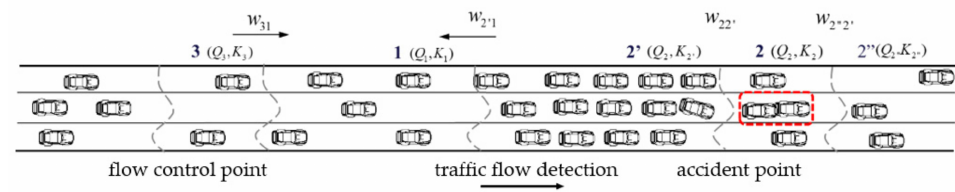
Figure 5. Diagram of traffic flow after traffic control in the extra-long